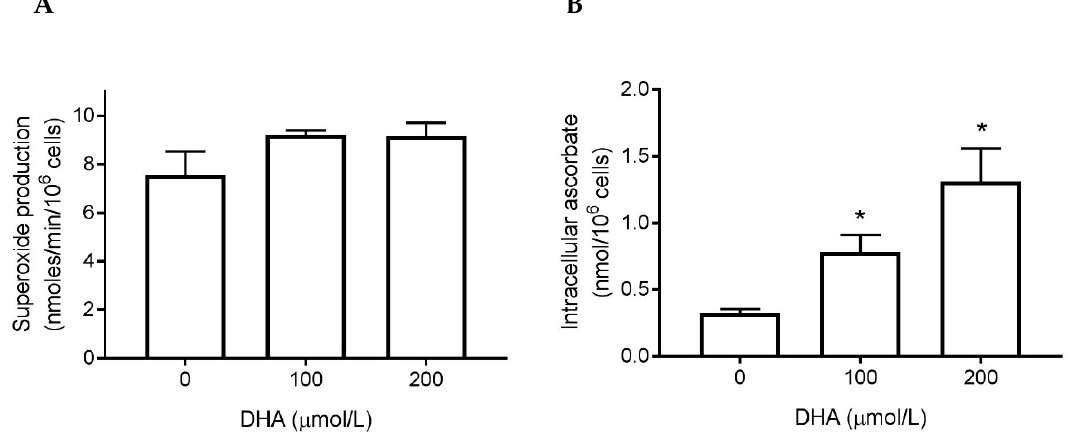
Figure 4. The e ff ect of ascorbate uptake on superoxide generation by stimulated neutrophils. ( A ) Cells pre-loaded with DHA were stimulated with PMA (100 ng / mL) and the rate of superoxide generation measured over 5 min. ( B ) The intracellular ascorbate concentration of preloaded cells was measured by HPLC. Data represent mean ± SEM, n = 3. * p < 0.05.